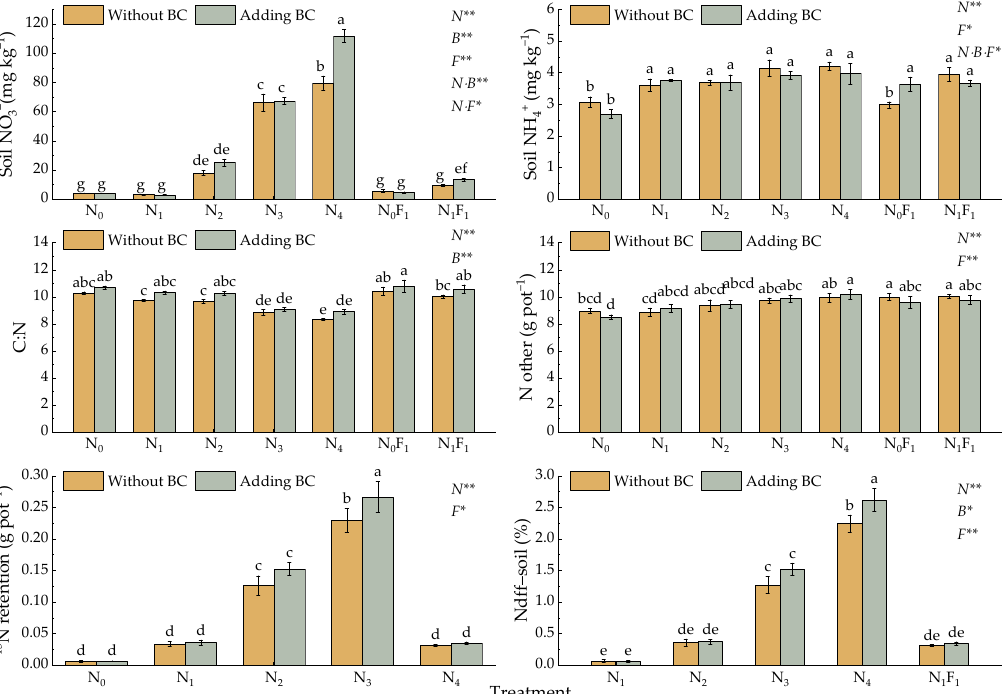
Figure 4. Soil mineral N, C:N, 15 N retention and its proportion. Note: C:N means the ratio of total carbon to total nitrogen in soil. Vertical bars represent standard errors of the means (n = 5). Different letters represent statistical class among the treatments at p < 0.05, and the presence of means with the same letter is not significantly different. Source of variation, N = 15 N-labeled urea; B = brown coal; F = organic manure. * and ** indicate significant differences at p < 0.05 and p < 0.01, respectively. N 0 , N 1 , N 2 , N 3 , and N 4 represent the urea application rate, 0, 100, 200, 300, and 400 kg N ha − 1 , respectively. F 1 represents organic manure of 100 kg N ha − 1 .